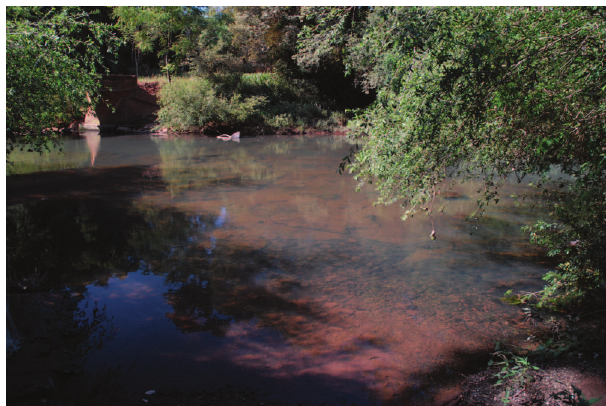
Fig. 5. Arroyo Falso Urugua-í, one of the paratype localities of Crenicichla ypo .